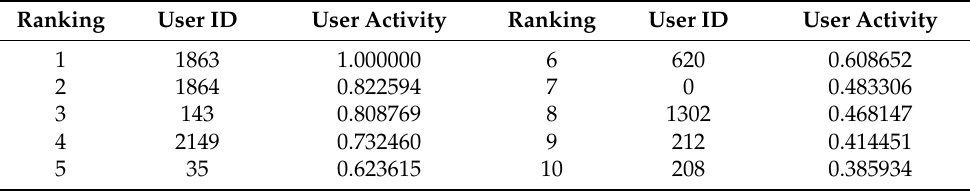
Table 3. Top 10 user